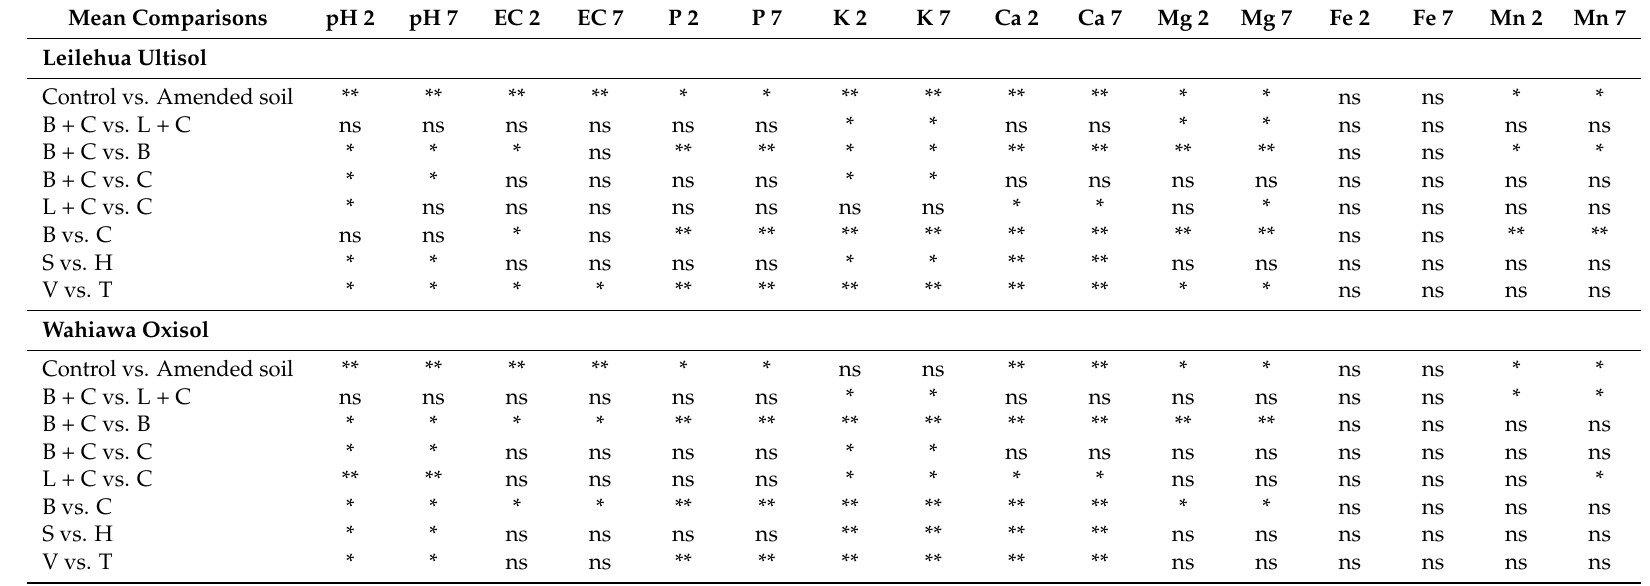
Table 2. The results of the ANOVA and the contrast on soil pH, EC, and nutrients 2 and 7 weeks after being treated with biochar or lime and compost. Mean